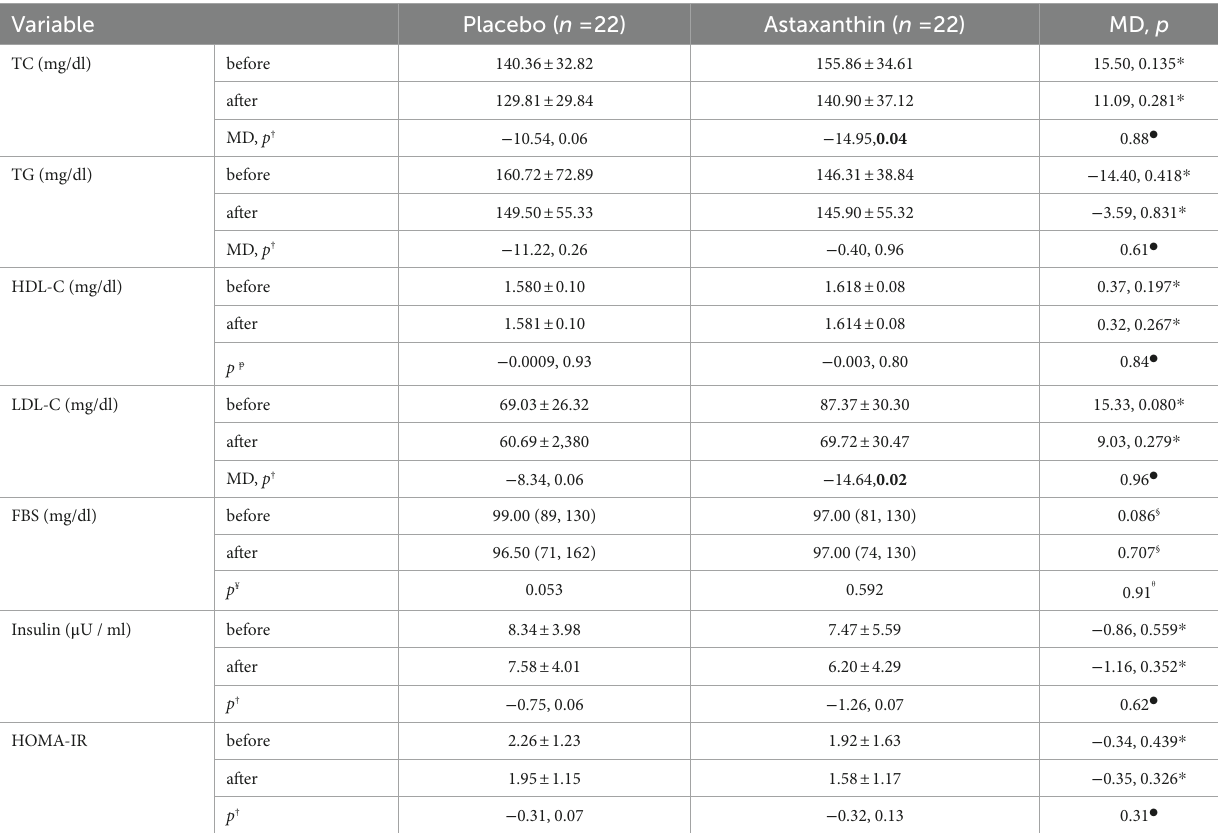
TABLE 4 lipid profile and glycemic indices.